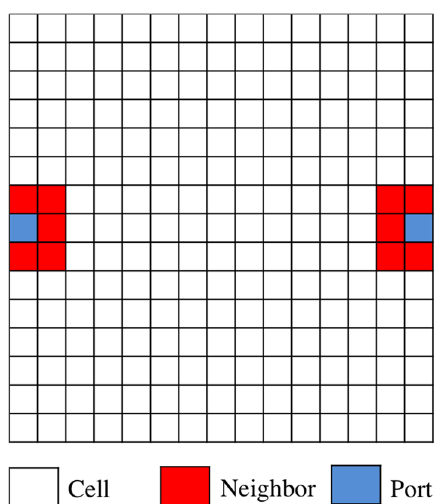
Fig. 2 Port‑location attribute. The figure exemplifies the connectivity of two cells in a close boundary based on their neighbors. This figure was inspired by the model of Fujita and Mori